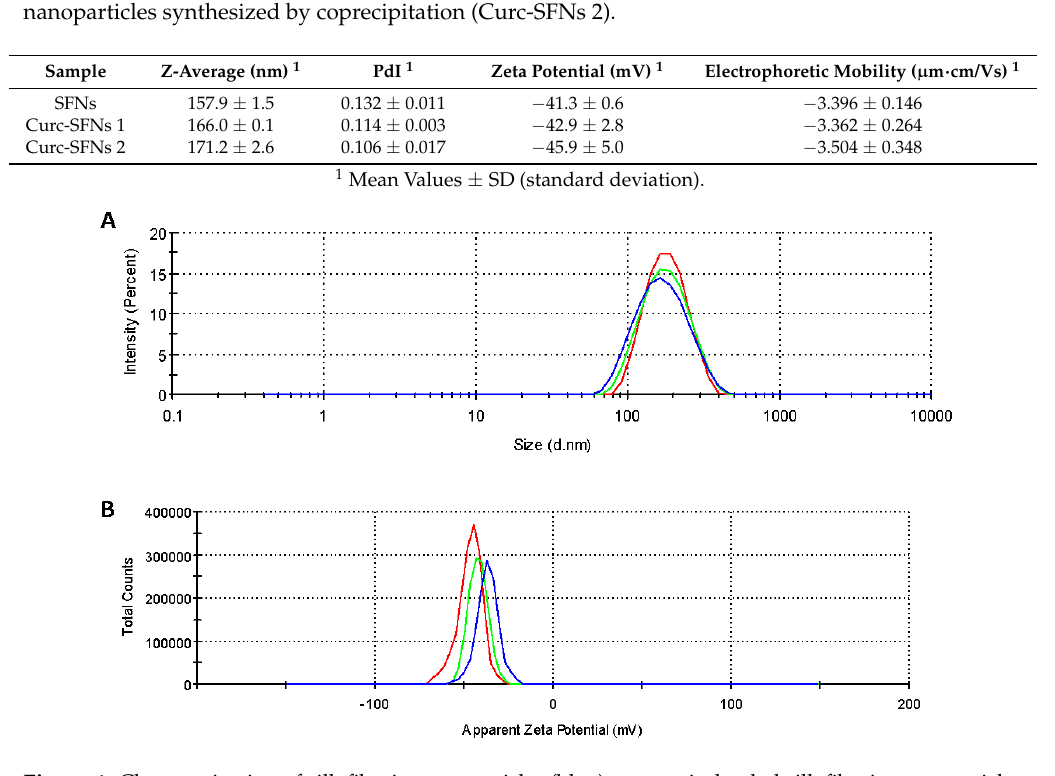
Figure 1. Characterization of silk fibroin nanoparticles (blue), curcumin-loaded silk fibroin nanoparticles synthesized by physical adsorption (green) and curcumin-loaded silk fibroin nanoparticles synthesized by coprecipitation (red): ( A ) size distribution; and ( B ) Zeta Potential measured at 25 °C in purified water.